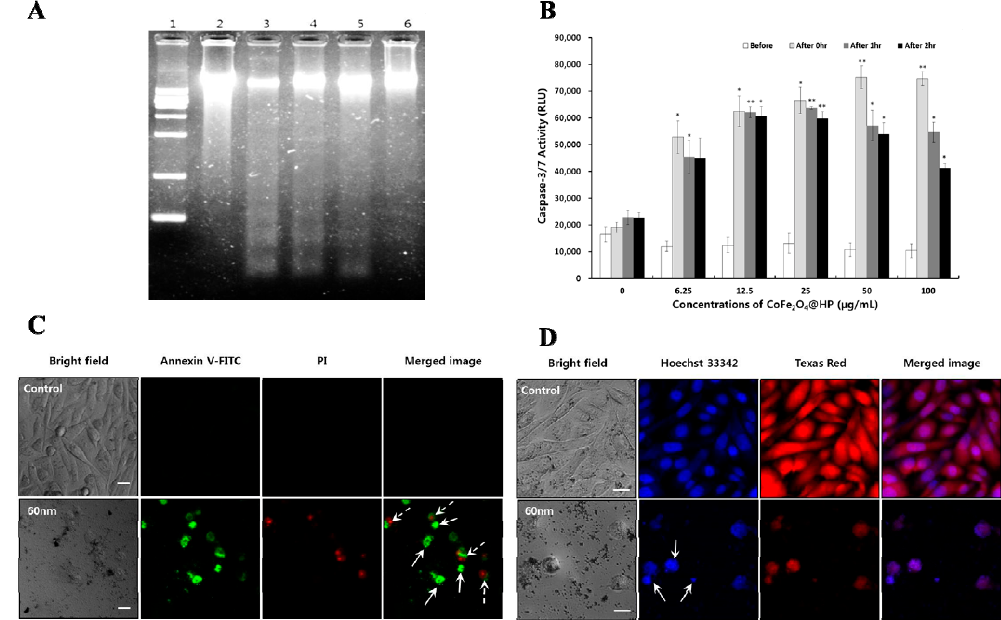
Figure 5. Apoptotic DNA fragmentation, Capase-3/7 activity, cell membrane translocation, and nuclear fragmentation in PC-3 cells. ( A ) Apoptotic DNA fragmentation in PC-3 cells. Apoptosis was